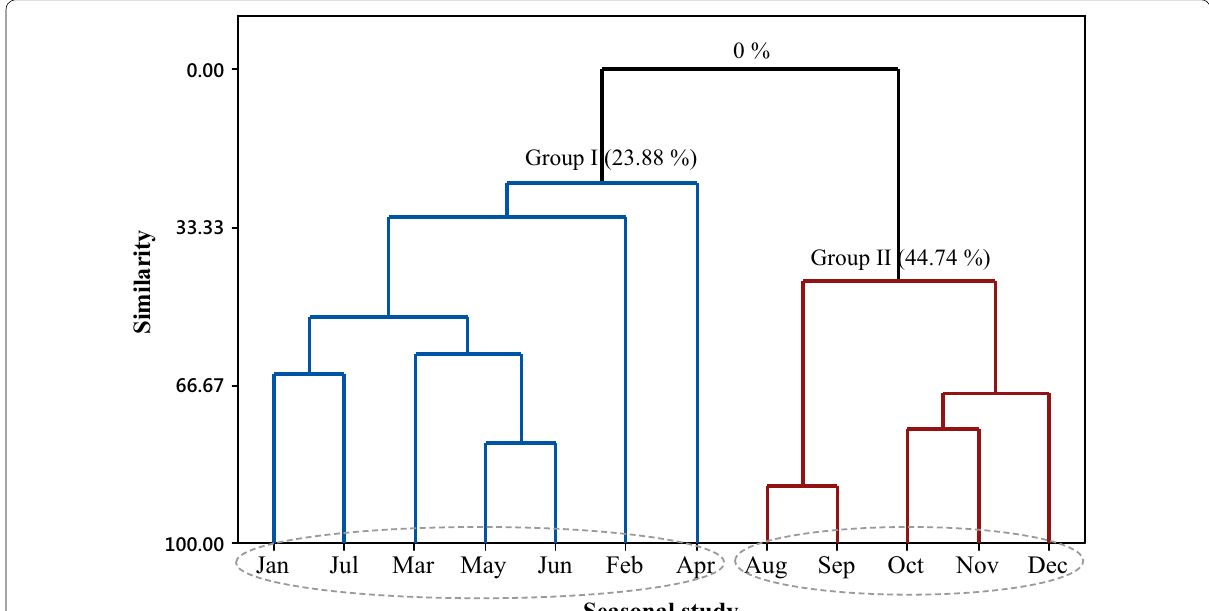
Fig. 3 Dendrogram representing the similarity relationship of the classes of compounds identified in the oils of L. thymoides in the seasonal study, in association with temperature, solar radiation, relative humidity and precipitation